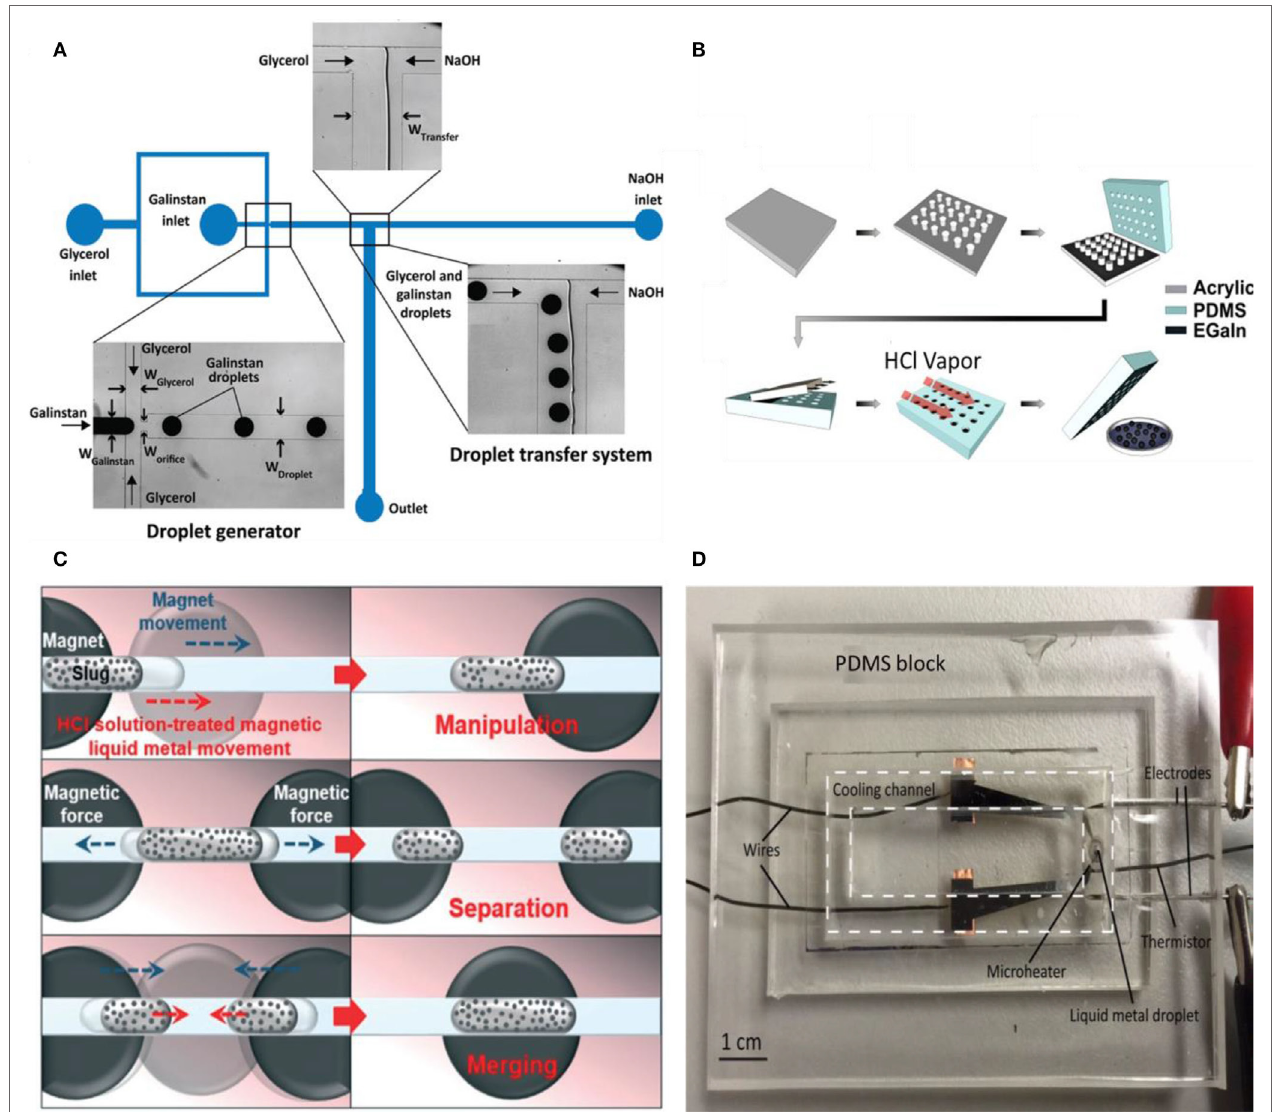
FiGURe 1 | (A) Chip schematic for galinstan droplet generation and transition into NaOH solution (Gol et al., 2015). (B) Process of liquid metal generation and oxide layer removal with HCl vapor (Mohammed et al., 2014). (C) Schematic of liquid metal manipulation with magnetic field (Jeon et al., 2017). (D) Liquid metal cooling system (Zhu et al.,